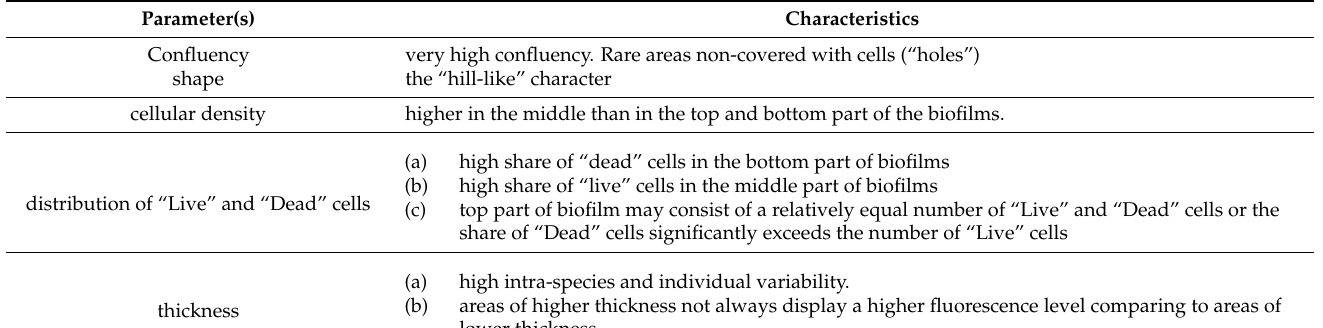
Table 2. Main characteristics of staphylococcal biofilm in vitro cultured in this research.